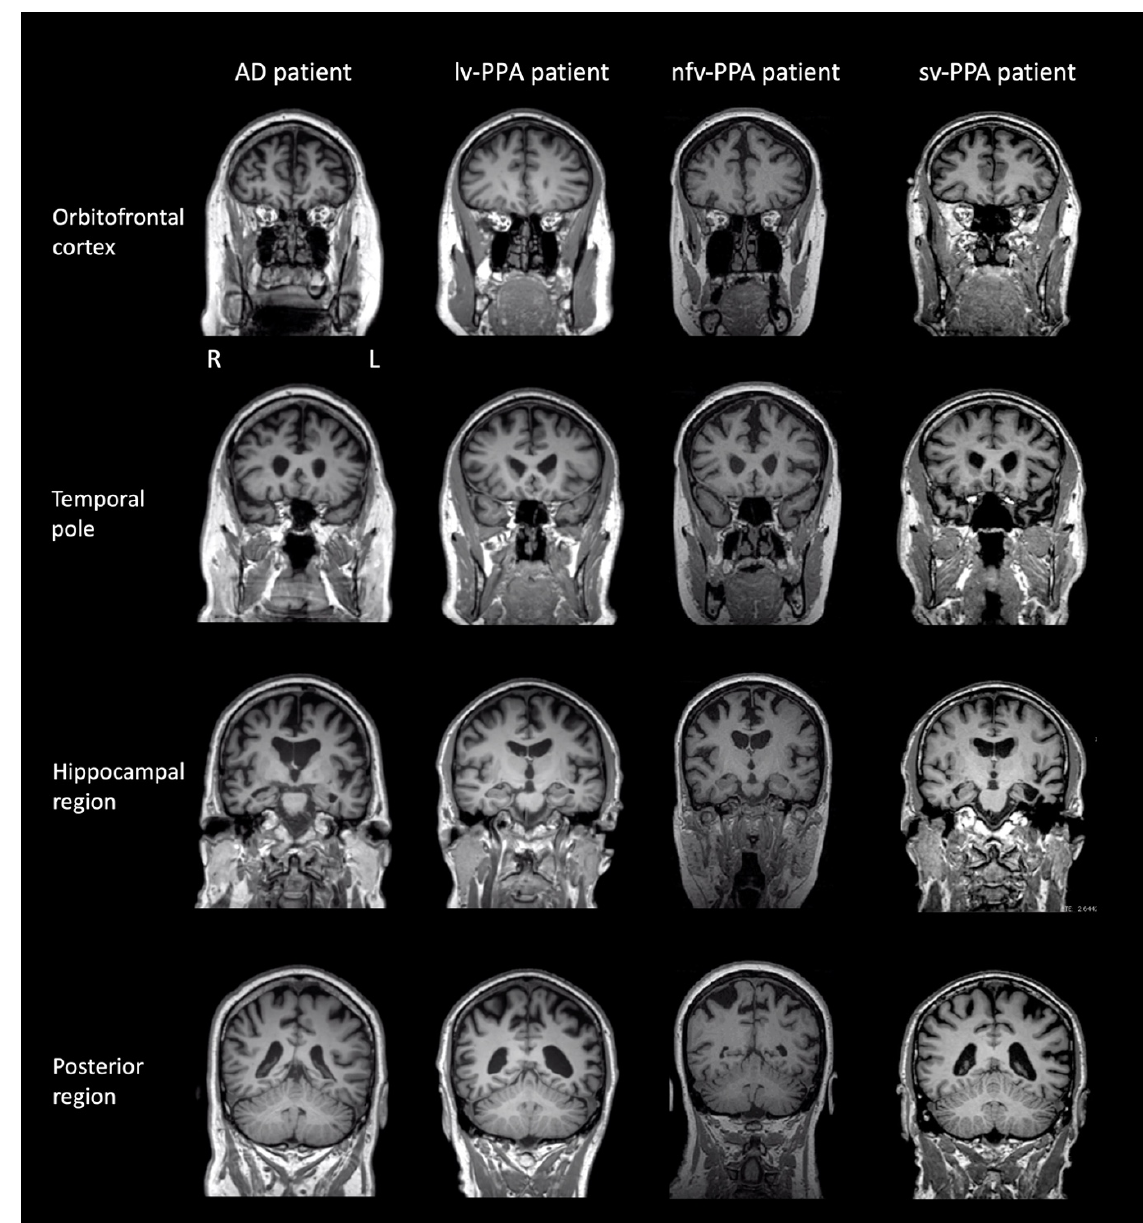
Figure 5. Brain T1 magnetic resonance images (MRI) of patients at the time of neuropsychological testing. Note: L = left; R = right. Brain images are presented in the coronal plane. lv-PPA patient: Mild generalised cortical atrophy was evident, slightly more prominent on the left than the right, extending posteriorly to involve the parietal lobes. There was marginally greater atrophy in the peri-insular region on the left than the right. nfv-PPA patient: Mild generalised cortical atrophy with particular involvement of the left peri-insular region anteriorly. sv-PPA patient: Severe atrophy of the anterior temporal pole bilaterally, but much worse on the left than the right. AD patient: Mild-moderate generalised cortical atrophy with involvement of the mesial temporal lobes.